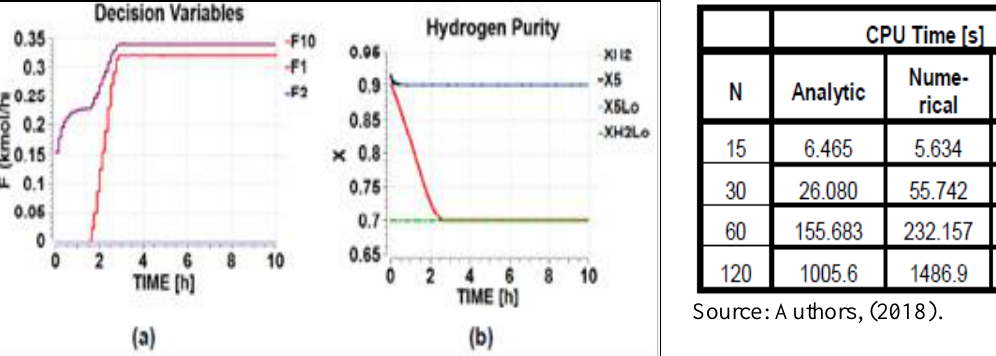
Table II: CPU Time and objective function